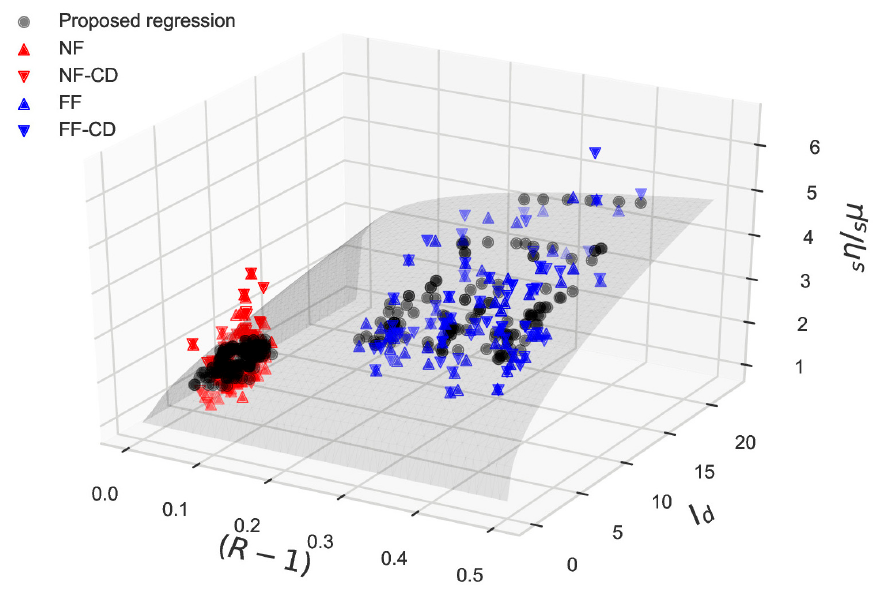
Figure 4. Proposed regression of principal features and s η / s μ .